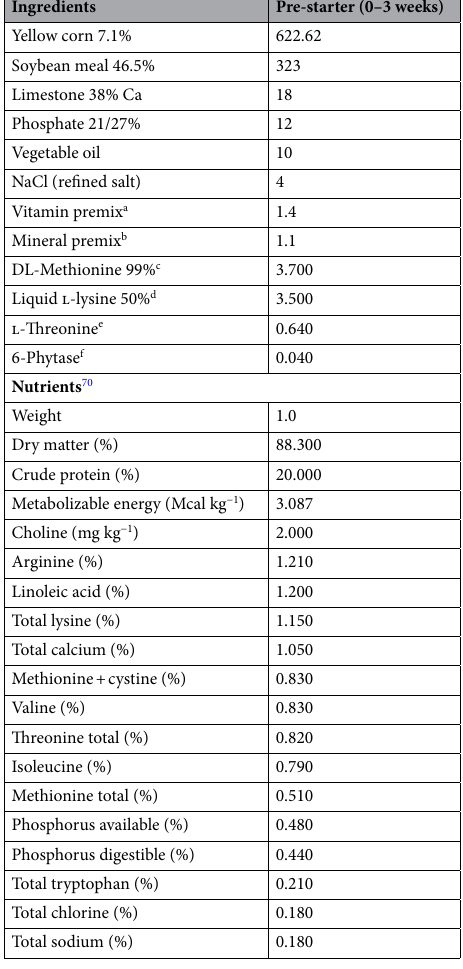
Table 4. Ingredient composition (kg) and nutrient content of feed supplied to the experimental SPF chickens. a Vitamin premix supplied per kg of diet: Retinol, 6 mg; cholecalciferol, 150 µg; dl-α-tocopherol, 67.5 mg; menadione, 9 mg; thiamine, 3 mg; riboflavin, 12 mg; pantothenic acid, 18 mg; niacin, 60 mg; pyridoxine, 5 mg; folic acid, 2 mg; biotin, 0.3 mg; cyanocobalamin, 0.4 mg. b Mineral premix supplied per kg of diet: Mn, 120 mg; Zn, 100 mg; Fe, 120 mg; copper, 10 to 15 mg; iodine, 0.7 mg; selenium, 0.2 mg; and cobalt, 0.2 mg. c MetAMINO® (Evonik, Essen, Germany). d Liquid l-lysine 50% (ADM, Chicago, IL, USA). e